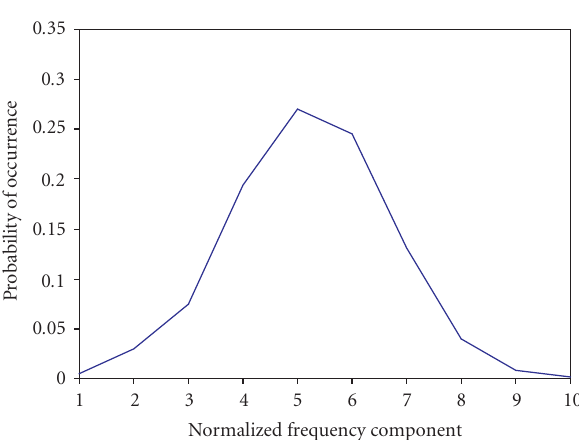
Figure 4: Histogram peak of Subsystem1.